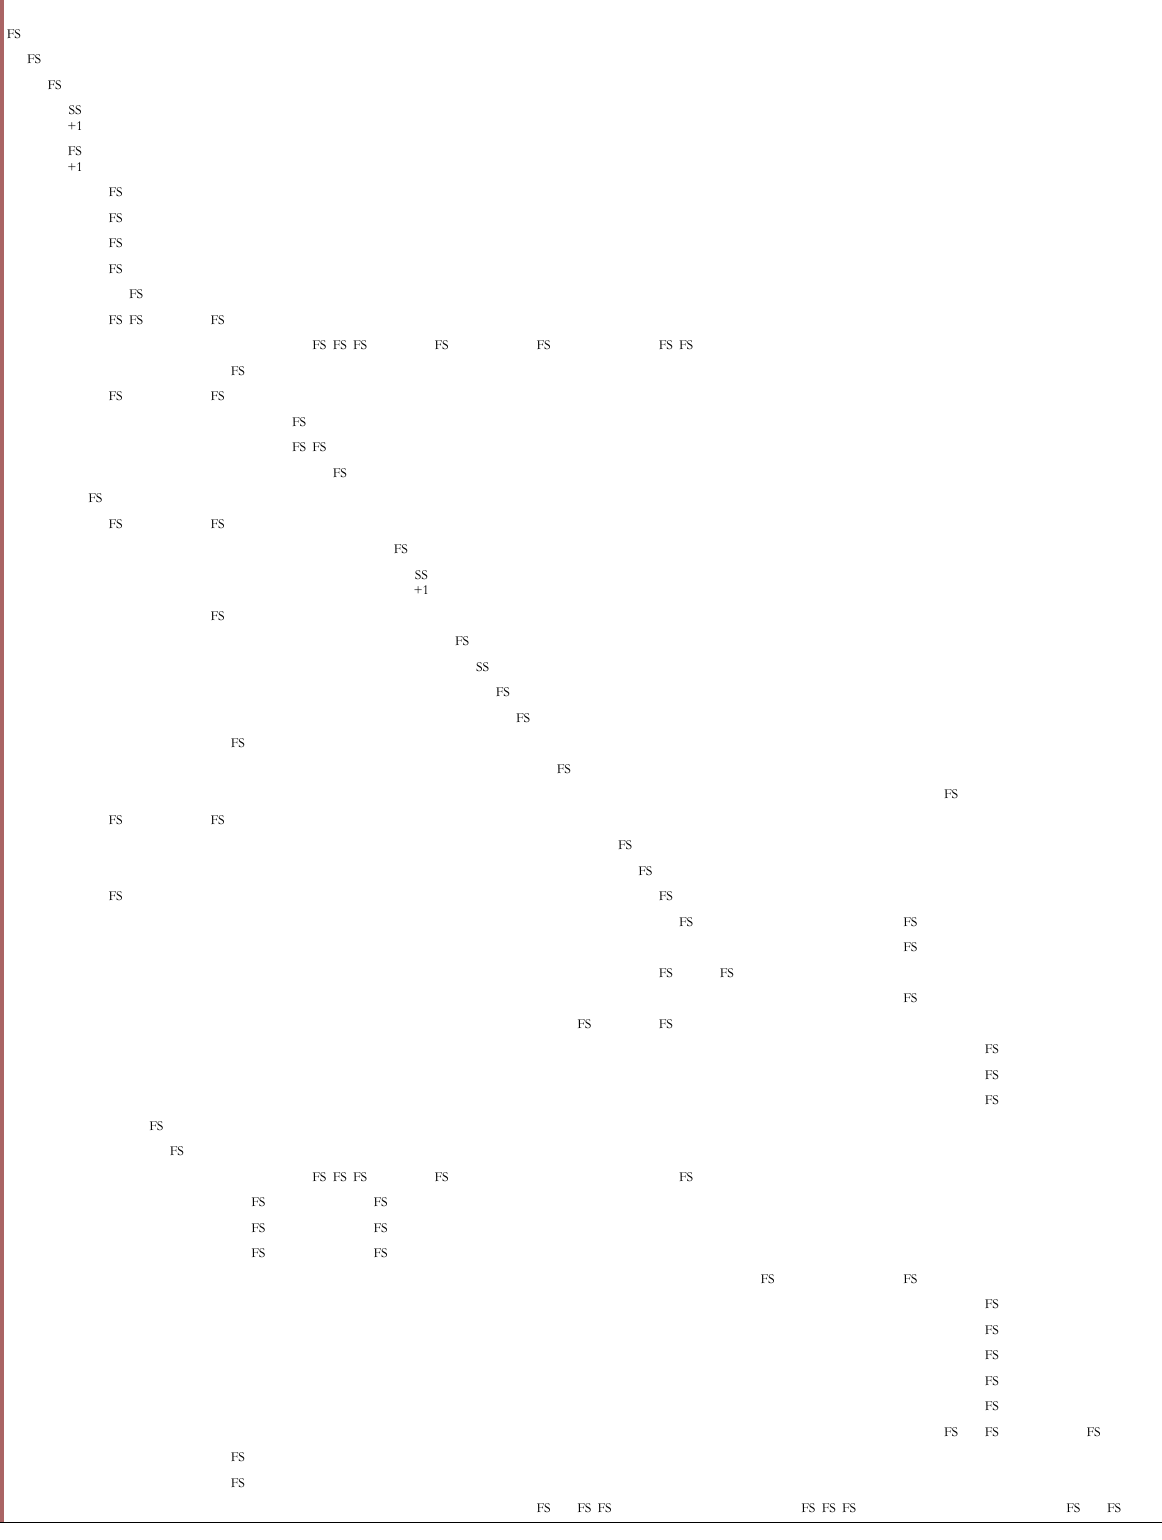
Table 6. The Activity Precedence